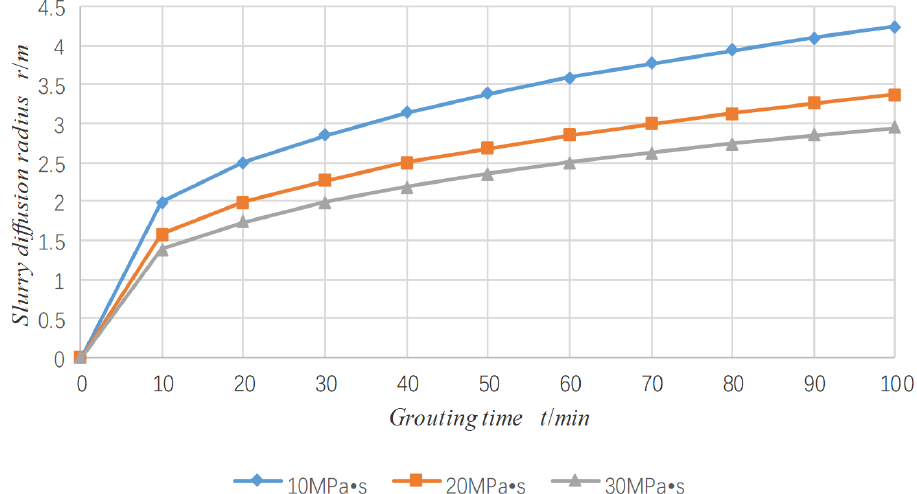
Figure 8. Variation in diffusion radius r with time under varying slurry viscosities.